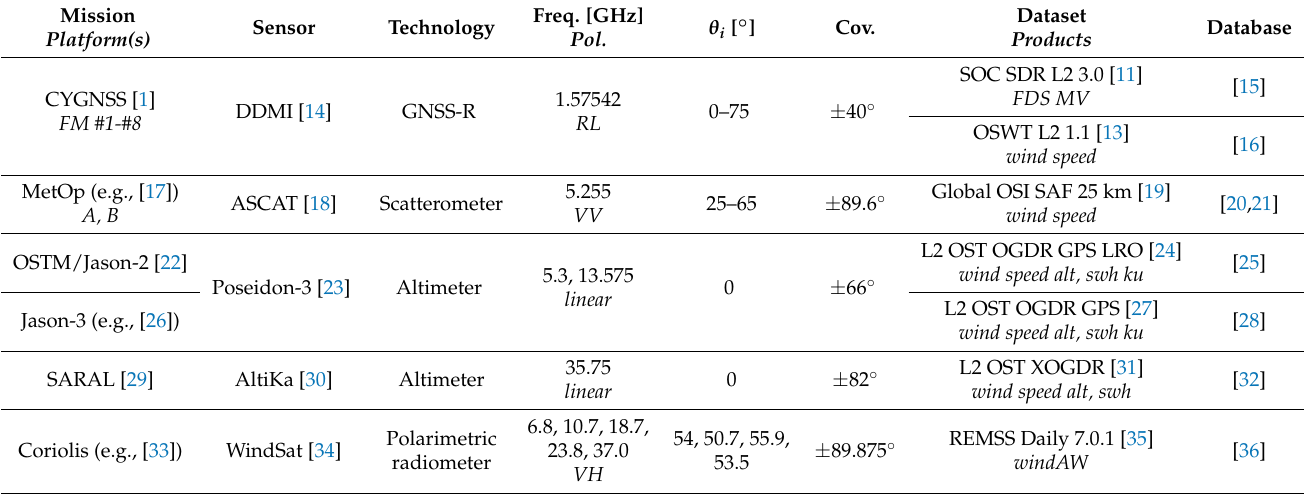
Freq. [GHz] θ i [ ◦ ] Cov. Pol.